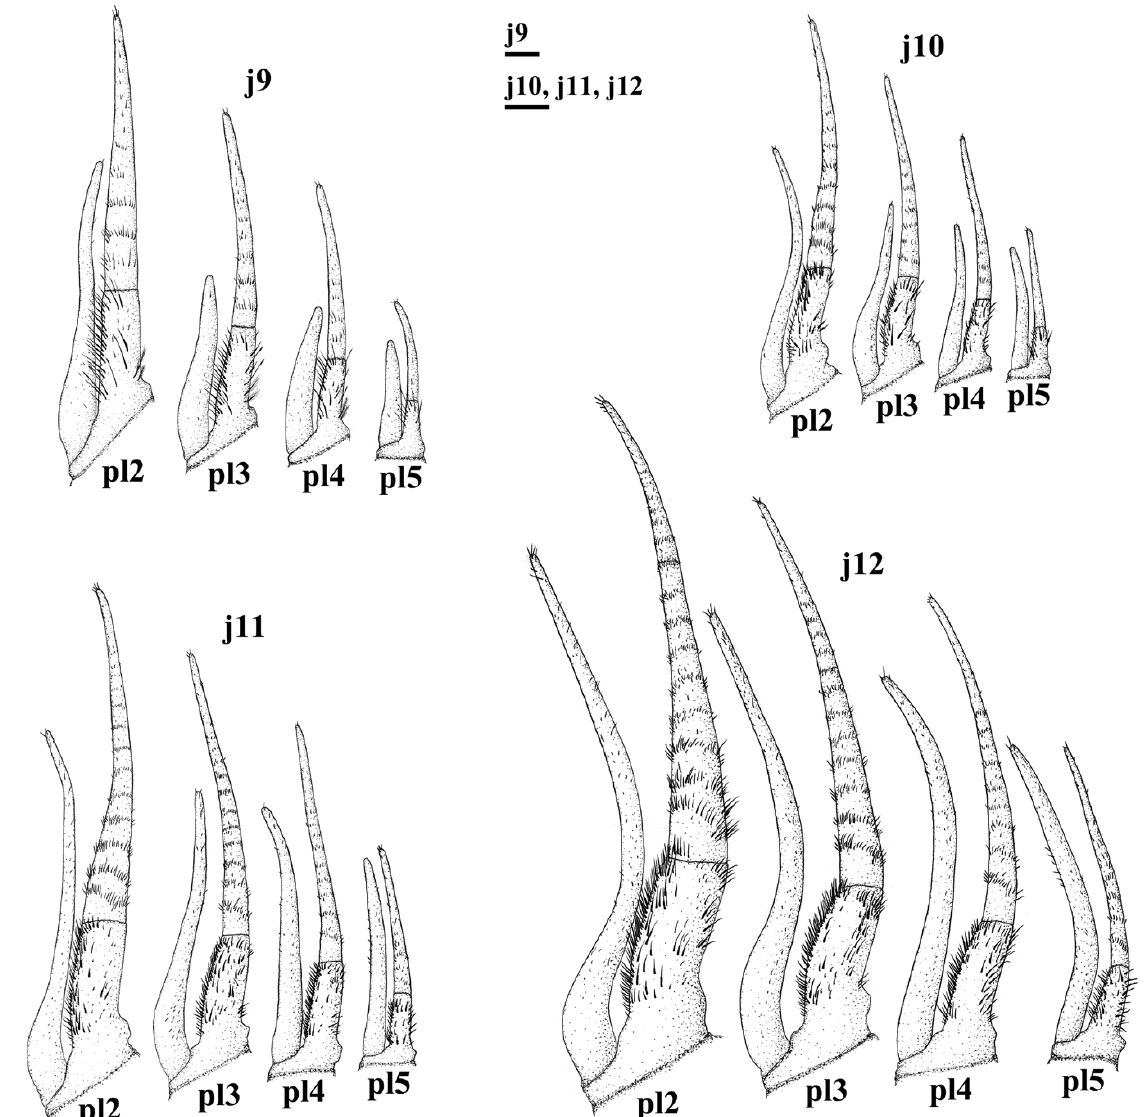
Figure 9 - Callinectes danae . pl2 to pl5 : pleopods from the 2 nd to 5 th female abdominal somites, respectively, from 9 th ( j9 ), 10 th ( j10 ), 11 th ( j11 ) and 12 th ( j12 ) stages on. Scale: j9 , 0.2mm; j10 , j11 and j12 ,